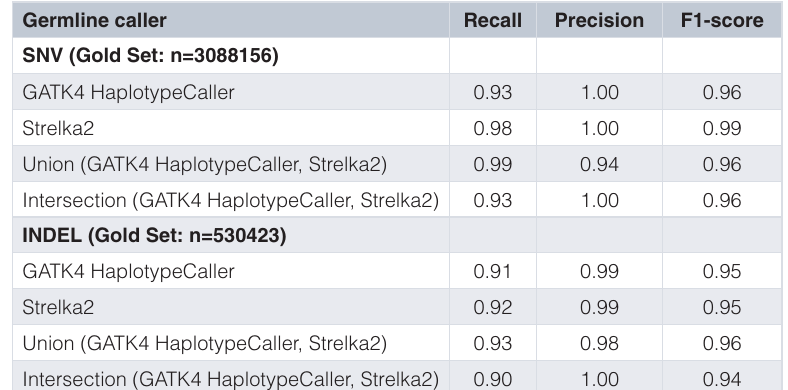
Table 4. Sarek WGS germline variant benchmarking. Summary of accuracy measures for the two variant callers used in Sarek to detect